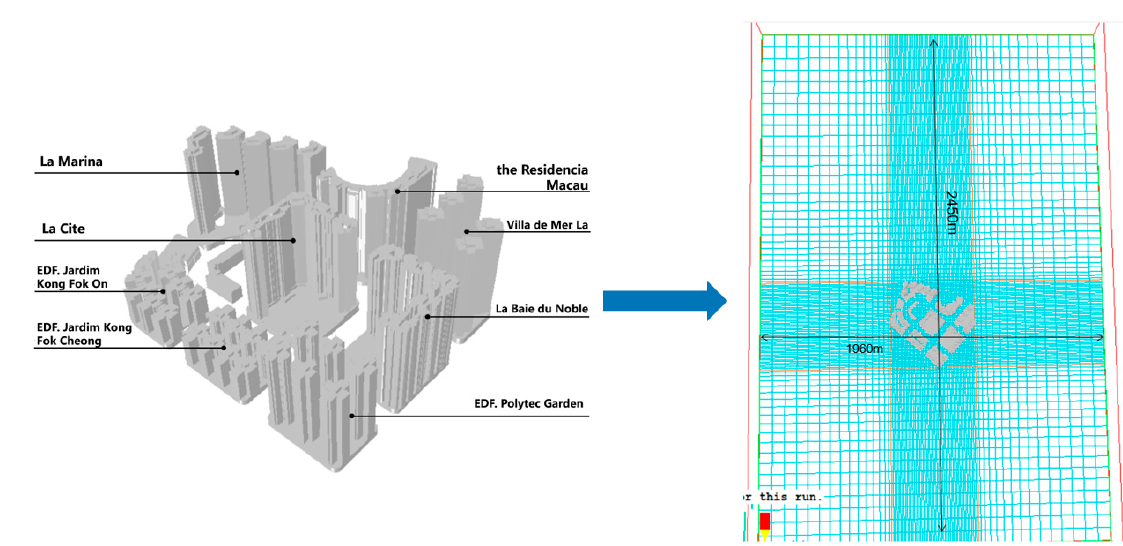
Figure 3. The optimized model and mesh enlargement.